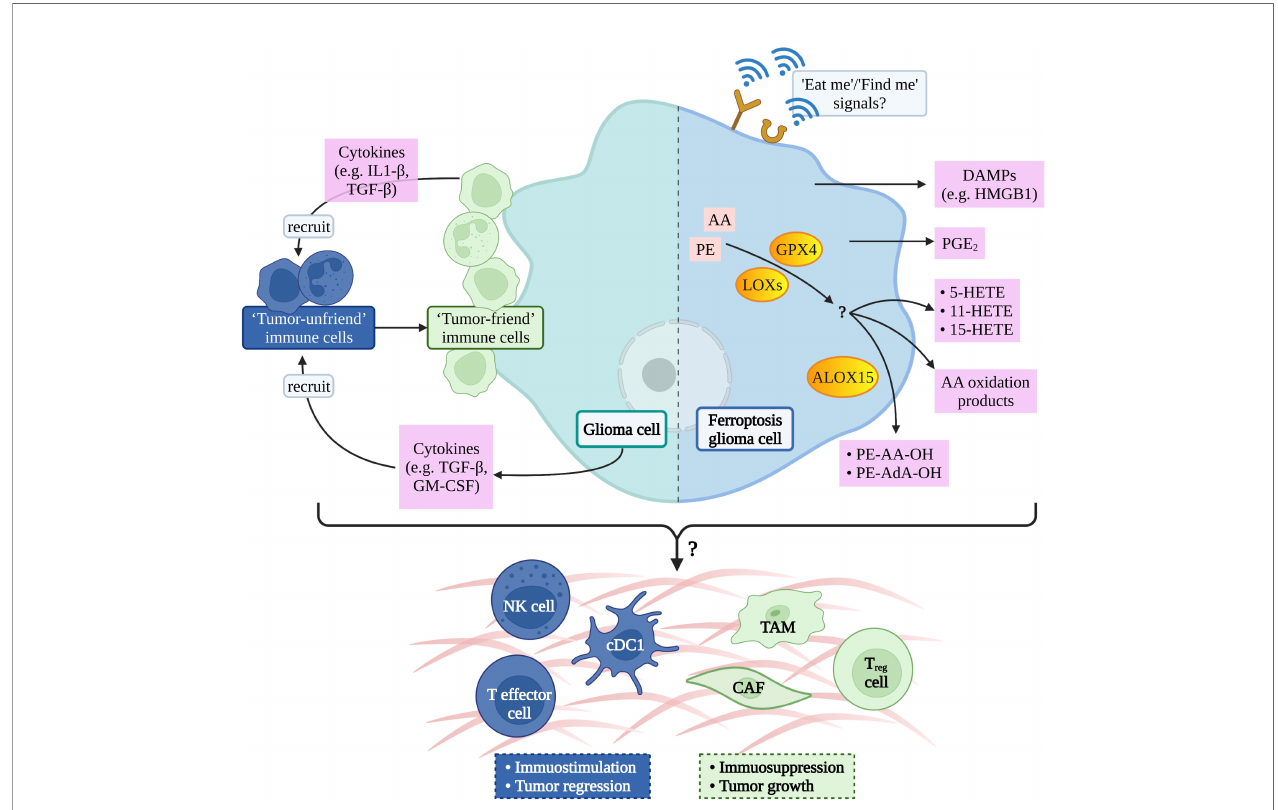
FIGURE 2 | Possible ferroptotic signals in glioma immune-microenvironment. AA, arachidonic acid; PE, phosphatidylethanolamine; GPX4, glutathione peroxidase 4; LOXs, lipoxygenases; ALOX15, arachidonate lipoxygenase 15; DAMPs, damage-associated molecular patterns; HMGB1, high mobility group box-1; PGE2, prostaglandin E2; HETE, hydroxy eicosatetraenoic acid; AdA, adrenic acid; IL1, interleukin-1; TGF, transforming growth factor; GM-CSF, granulocyte-macrophage colony-stimulating factor; NK, natural killer; cDC1, conventional type 1 dendritic cell; TAM, tumor- associated macrophage; CAF, cancer-associated fi broblast; T reg cell, regulatory T